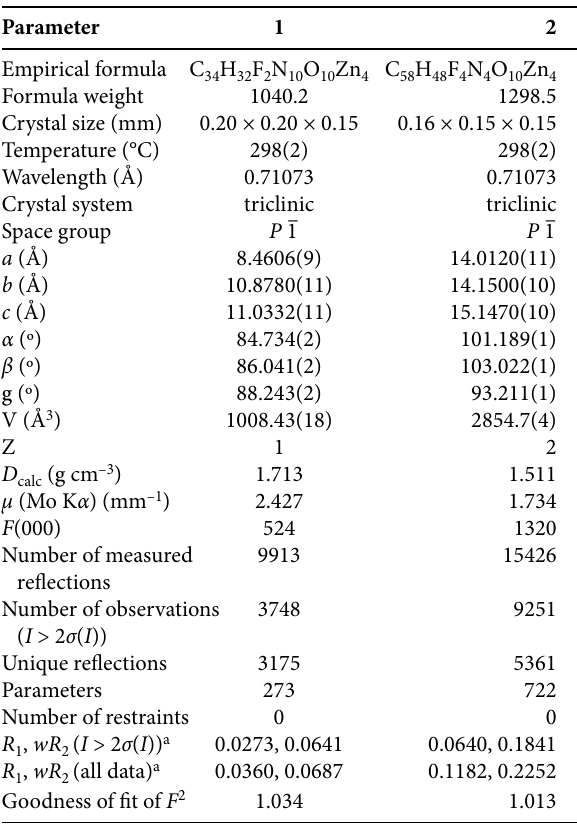
Table 1. Crystal and refinement data for the complexes